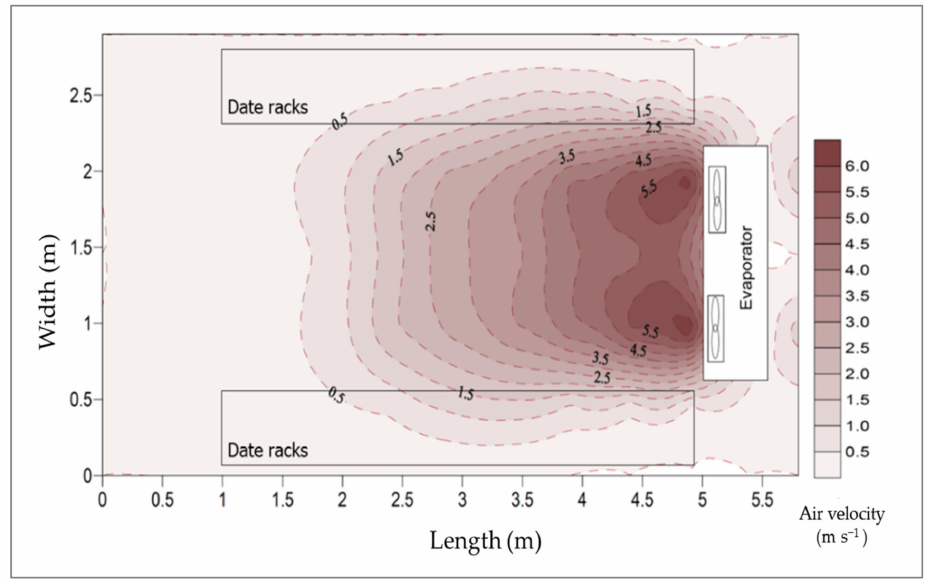
Figure 12. Distribution of air velocities horizontally at the height of 2.2 m inside the cold storage room.